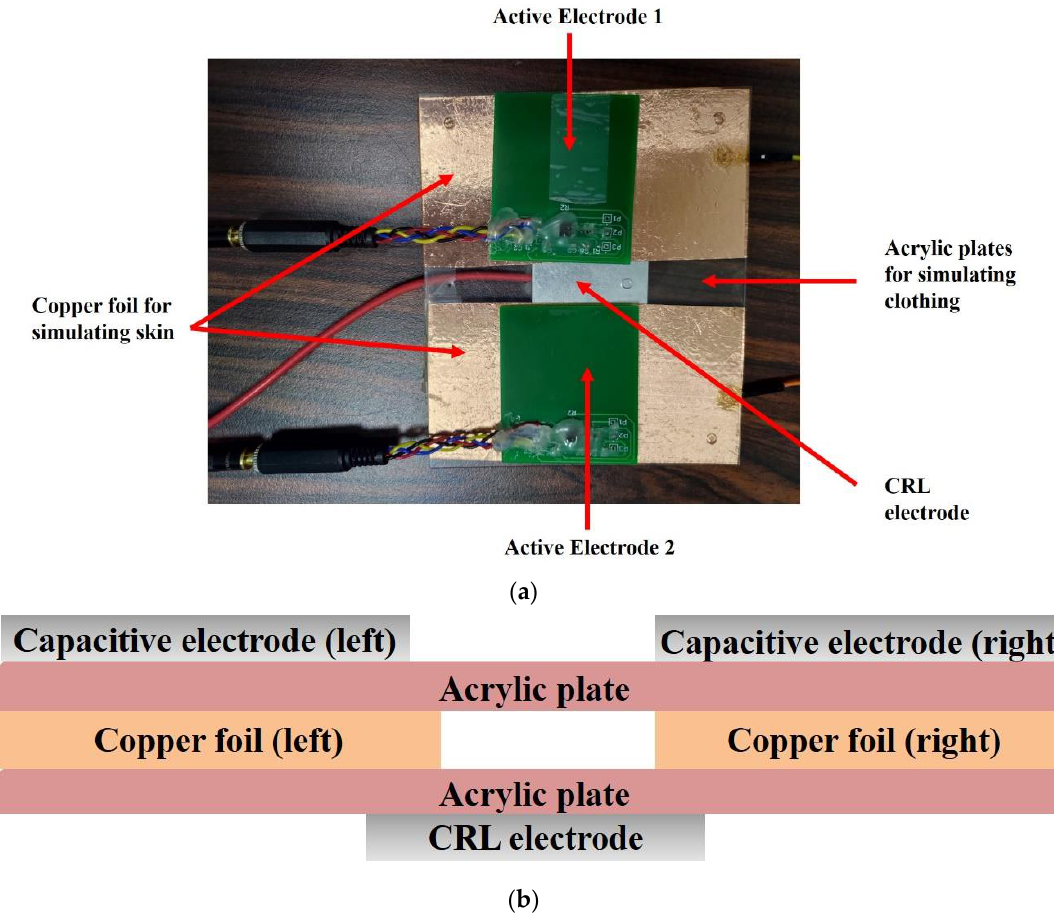
Figure 7. ( a ) A top view photo of the proposed electrode, and ( b ) cross sectional view of ( a ) where two pieces of aluminum foil, sandwiched between the acrylic plates, are employed to simulate the skin of a